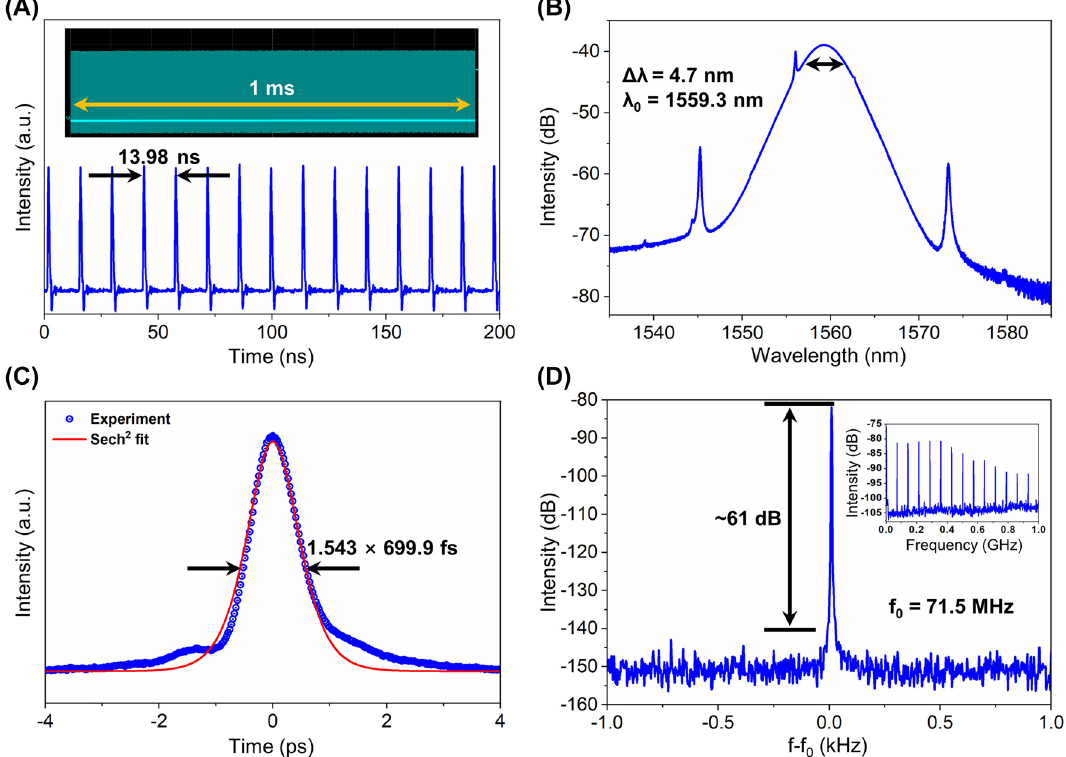
Figure 8: 7th harmonic mode-locked EDFL. (A) Oscilloscope trace; (inset: 1.0 ms pulse trains); (B) optical spectrum; (C) autocorrelation trace; and (D) RF spectrum with 1 Hz resolution in the range of 2 kHz (inset: RF spectrum with 100 kHz resolution in the range of 1